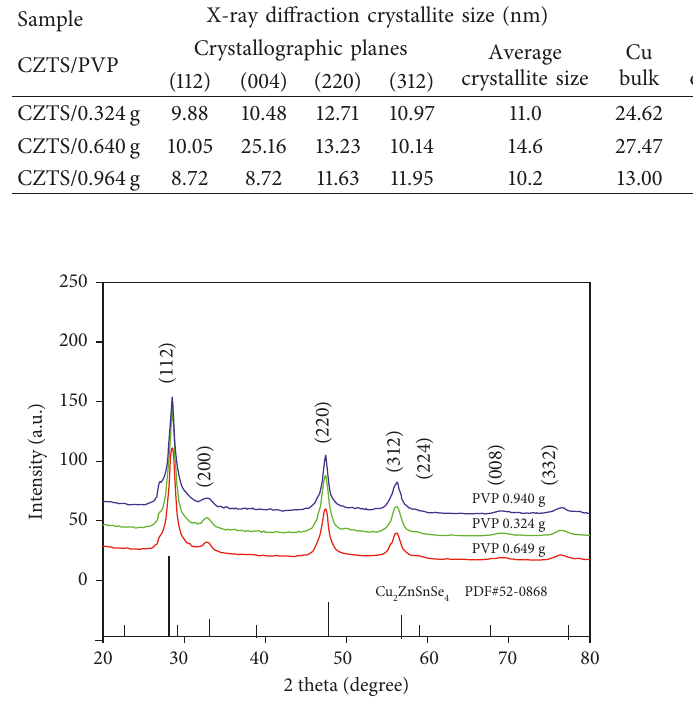
Figure 6: XRD patterns of CZTS samples prepared with different concentrations of PVP which show a good matching between the peaks in each one of the diffraction patterns and those of the pure phase of kesterite structure (CZTS) (JCPDS 01-75-4122).